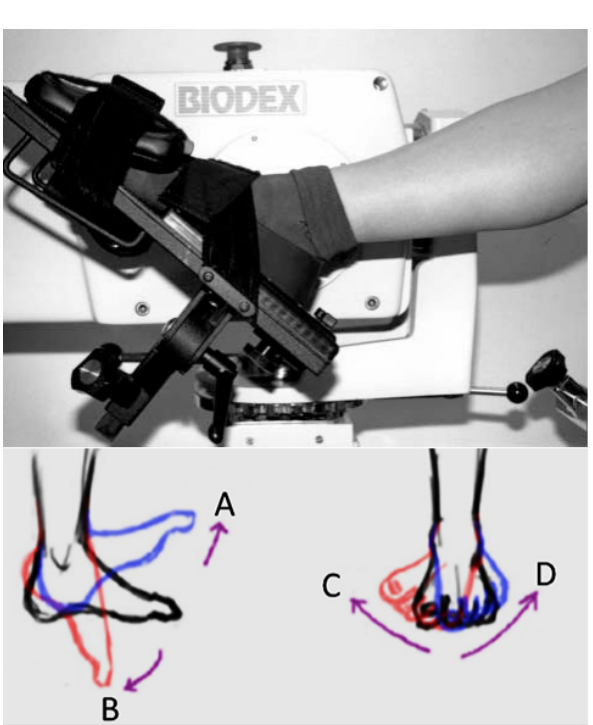
Fig. 2. The descriptions of measurements of the strength of muscles that move the ankle. (A) Plantarflexion. (B) Dorsiflex- ion. (C) Inversion. (D)